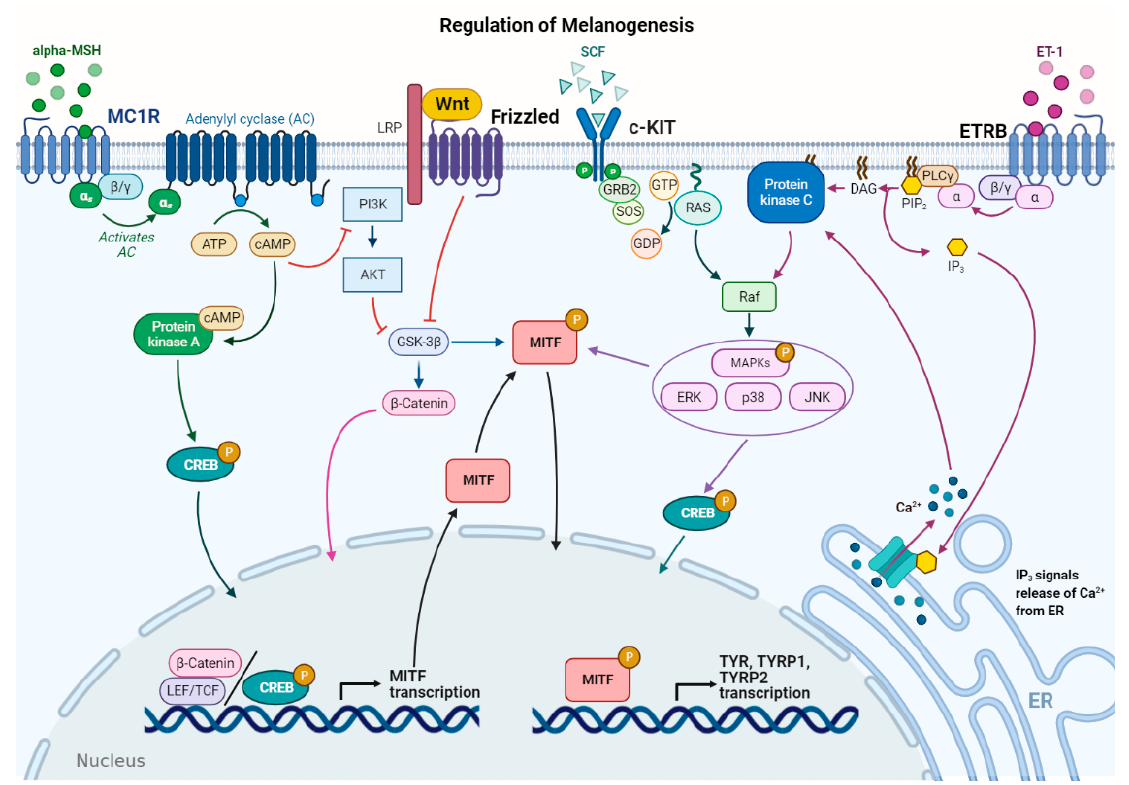
Figure 2. Main signaling pathways involved in melanogenesis regulation. α -melanocyte stimulating hormone ( α -MSH) binds to melanocortin 1 receptor (MC1R), which increases cAMP levels, activating PKA and PI3K/AKT pathway. The former phosphorylates CREB protein, promoting MITF transcription; the latter interplays with Wnt/ β -catenin pathway by phosphorylating GSK-3 β , which, in turn, releases β -catenin to promote MITF transcription. Stem cell factor (SCF) binds to c-KIT receptor, activating MAPK pathway and phosphorylating CREB. Peptide endothelin 1 (ET-1) binds to its receptor, ETRB, activating PKC and stimulating MITF transcription. MITF is phosphorylated at the post-transcriptional level to promote transcription of the melanogenic enzymes.